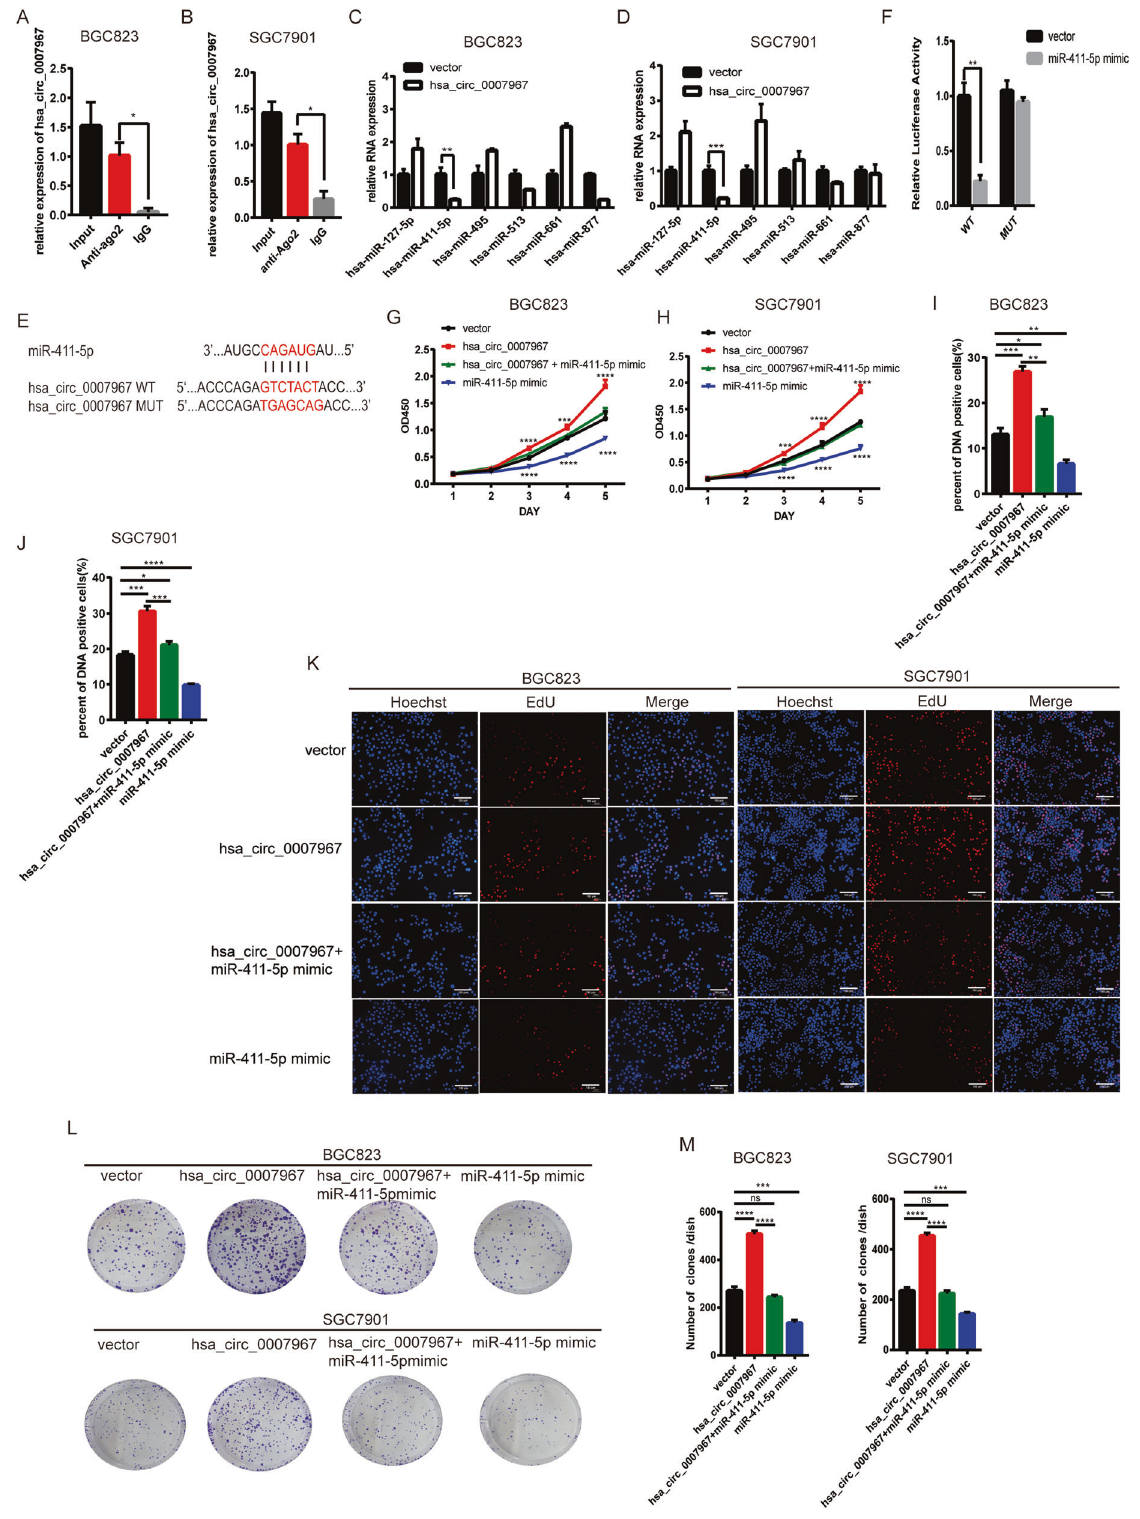
Fig. 4 Hsa_circ_0007967 serves as the sponge of miR-411-5p. A , B Level of hsa_circ_0007967 enriched for Ago2 by RIP assays in BGC823 and SGC7901 cells. C , D The expression of selected miRNAs in BGC823 and SGC7901 cells after overexpressing hsa_circ_0007967. E The potential binding site between miR-411-5p and hsa_circ_0007967. F The relative luciferase activity in HEK-293T cells cotransfected with miR-411-5p mimics and hsa_circ_0007967 plasmids with WT/MUT binding site by Dual luciferase reporter assays. G , H The growth rate of BGC823 and SGC7901 cells transfected with vector, hsa_circ_0007967 plasmids, miR-411-5p mimics or cotransfected with hsa_circ_0007967 plasmids and miR-411-5p mimics by cck8 assays. I – K DNA positive cells of BGC823 and SGC7901 cells transfected with vector, hsa_circ_0007967 plasmids, miR-411-5p mimics or cotransfected with hsa_circ_0007967 plasmids and miR-411-5p mimics by EdU assays. L , M The assessment of proliferation of BGC823 and SGC7901 cells transfected with vector and hsa_circ_0007967 plasmids by colony formation assays. Cell Death Discovery (2022)